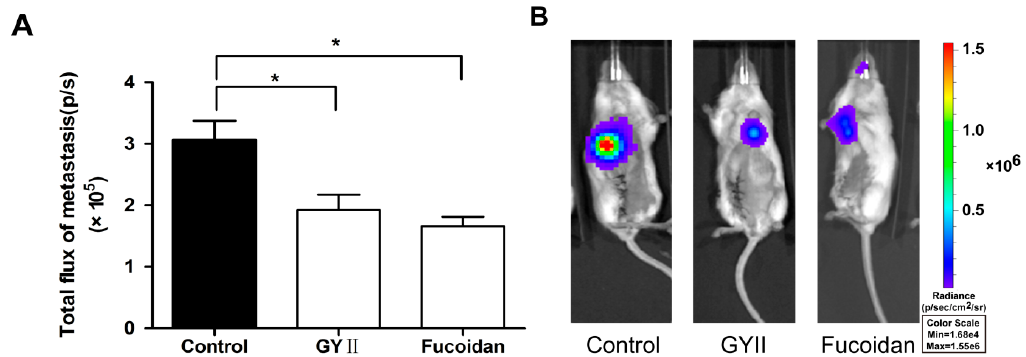
Figure 2. GYII reduced lung metastasis. ( A ) The micro-metastatic bioluminescent signals were detected after resection of the 4T1-luc2 primary tumor on day 32. GYII significantly suppressed lung metastases (* p < 0.05); ( B ) Representative bioluminescent images of mice with or without treatment.